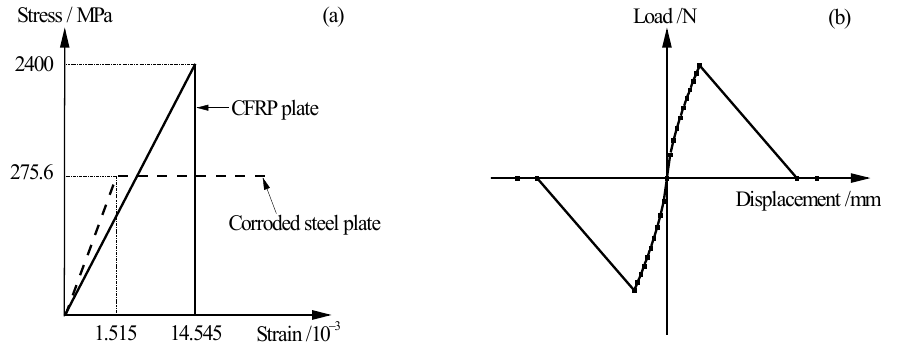
Figure 14. Material constitutive model in finite element models: ( a ) stress-strain relationship of the corroded steel plate and the CFRP plate, ( b ) real constant ( F - D relationship) of spring element.